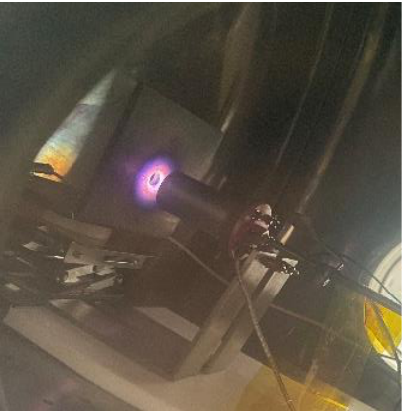
Figure 8. C12A7 hollow cathode working under low-current operating conditions.